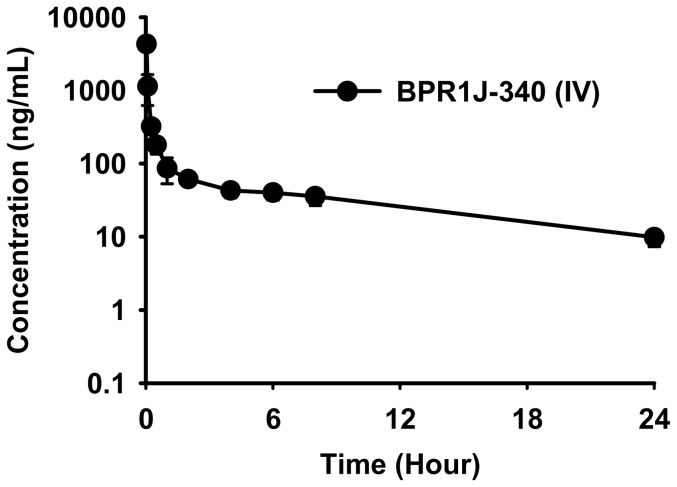
Pharmacokinetic profile of BPR1J-340 in rats.A single intravenous bolus dose (1.5 mg/kg) of BPR1J-340 was administered to adult male Sprague-Dawley rats (n = 3). Data illustrate mean values (n = 3) ± S.D. of plasma concentrations of BPR1J-340 at each timepoint.